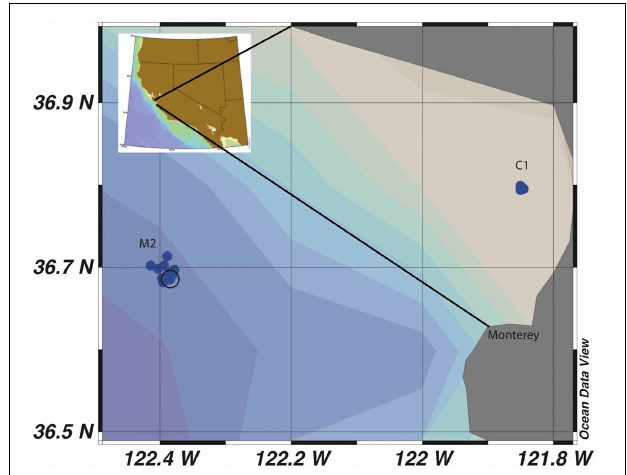
FIGURE 1 | Map of sample sites C1 and M2 in Monterey Bay, California. Each individual blue dot represents a sampling event and the black circle is the identified coordinate of the mooring station at